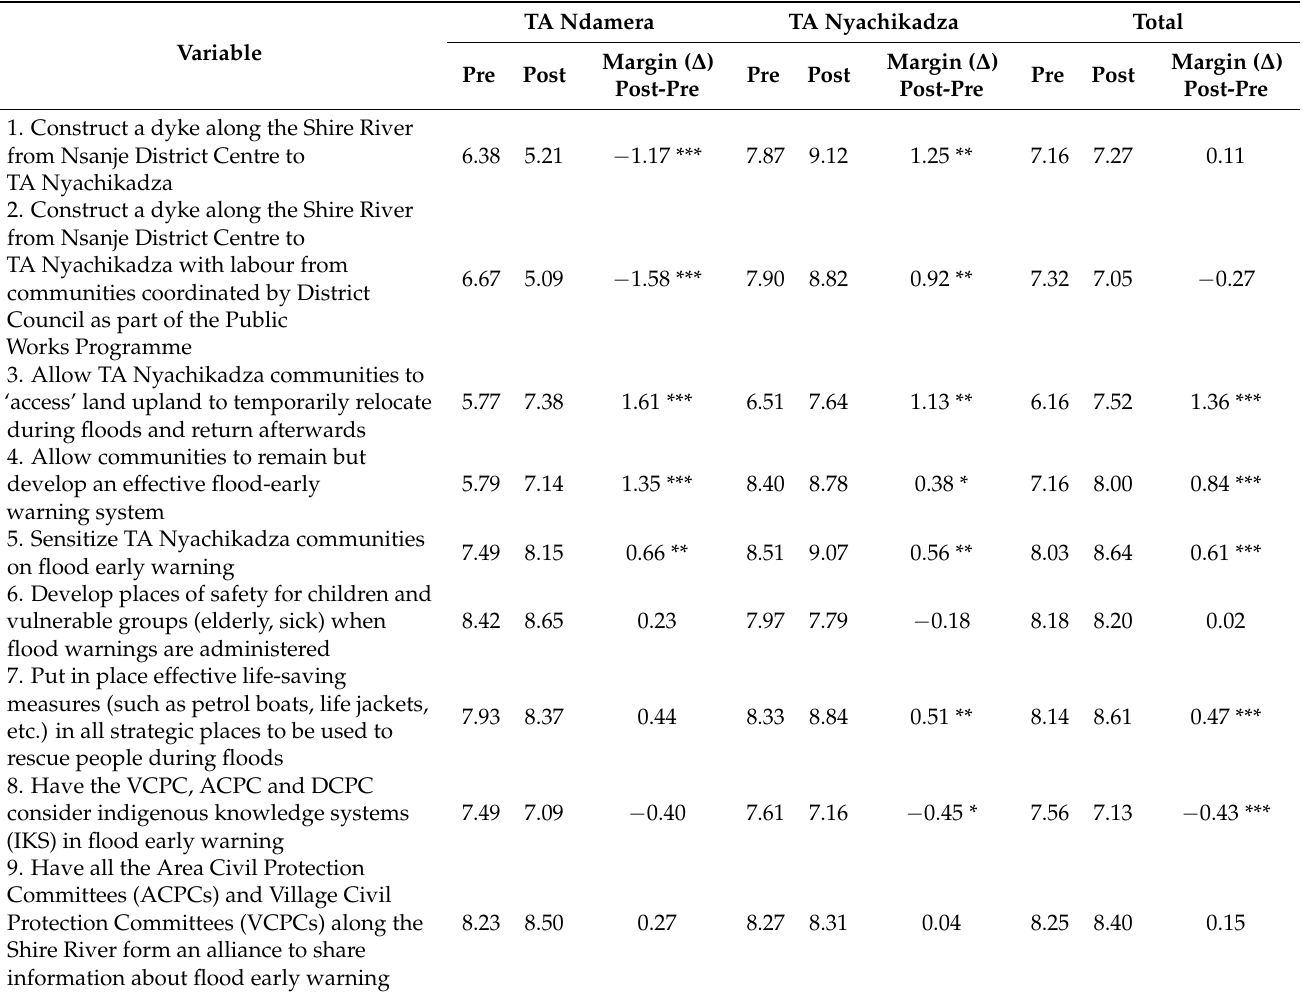
Table 3. What the government should do regarding reducing vulnerability in the existing